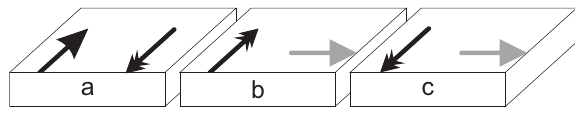
(cid:98) (cid:99)(cid:97)